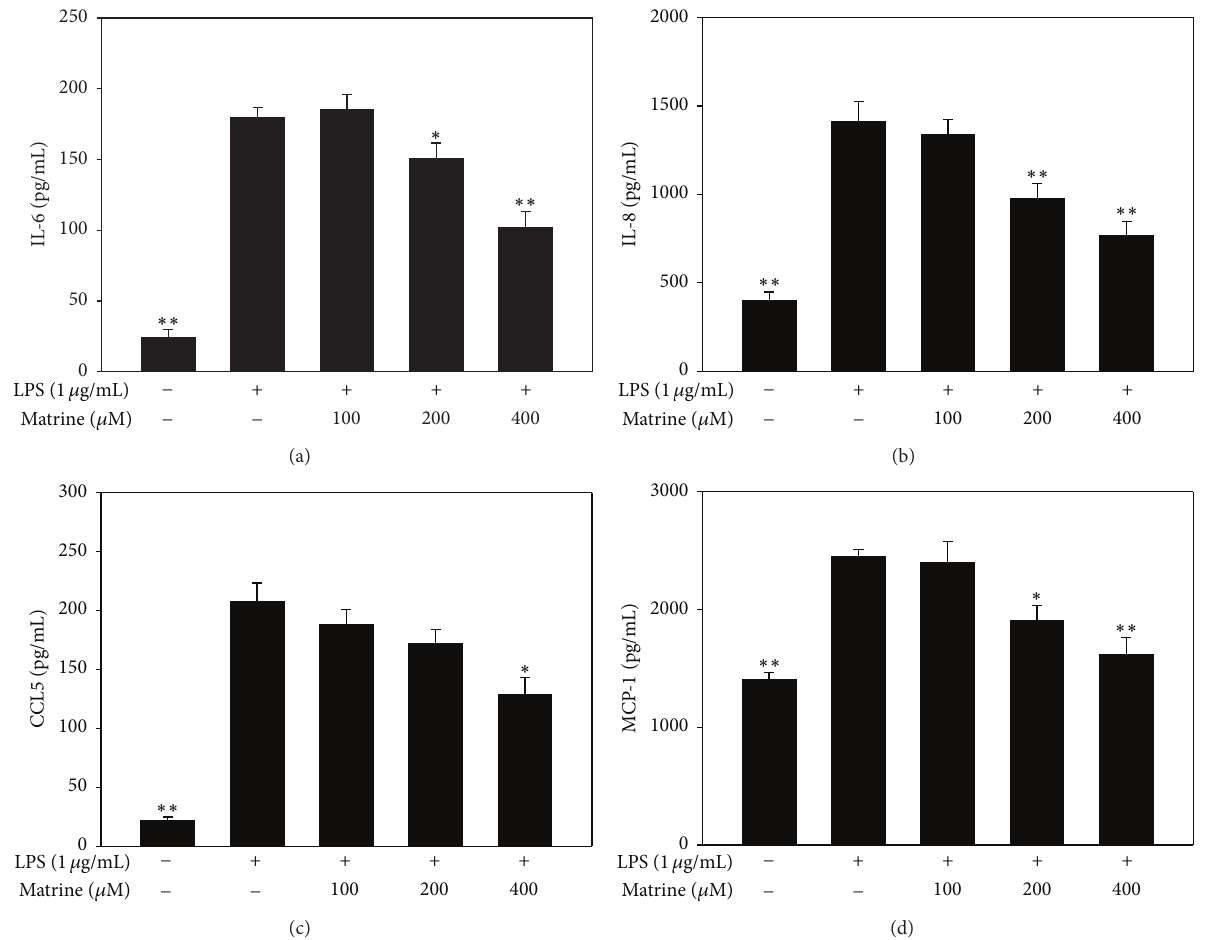
Figure 1: Matrine affects cytokine and chemokine productions in LPS-stimulated A549 cells. ELISA was used to measure the levels of IL-6 (a), IL-8 (b), CCL5 (c), and MCP-1 (d). All data are presented as mean ± SEM. ∗ 𝑃 < 0.05 compared with the LPS control group. ∗∗ 𝑃 < 0.01 compared with the LPS control